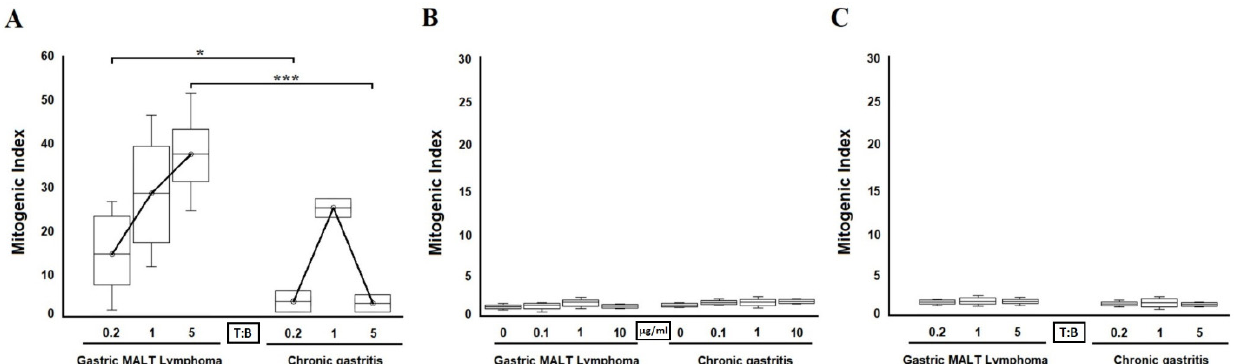
Figure 3. B cell proliferation to CagY. CagY-stimulated T cell clones derived from the gastric mucosa of patients with MALT lymphoma provide huge help for proliferation to autologous B cells ( A ). Irradiated T cell blasts of each CagY-reactive clone derived from patients with gastric MALT lymphoma or chronic gastritis were co-cultured for four days with peripheral blood autologous B cells (3 × 10 4 ) at 0.2, 1, and 5 to 1 T-to-B-cell ratios in the presence of medium alone or CagY. Sixteen hours before harvesting, 0.5 µ Ci of [ 3 H] thymidine was added, and its uptake was measured as mitogenic index. B cells cultured with or without CagY did not show any proliferation both in gastric low-grade MALT lymphoma and chronic gastritis patients at any CagY concentration used (0.1, 1, 10 µ g/mL) ( B ). B cells cultured without CagY, with autologous irradiated gastric T cells did not show any proliferation both in gastric low-grade MALT lymphoma and in chronic gastritis patients at any T-to-B-cell ratios (0.2, 1, and 5 to 1) ( C ). * p < 0.05; *** p < 0.001.